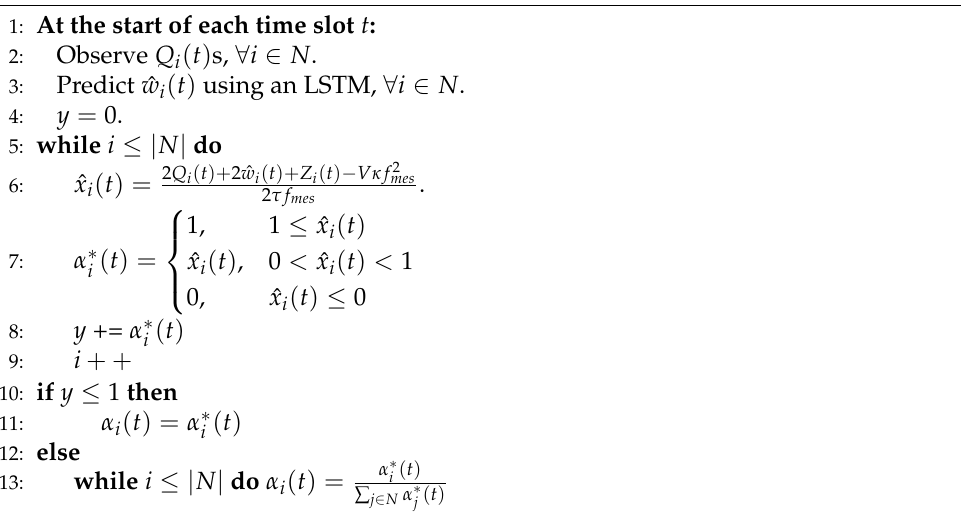
Algorithm 1 Online service time allocation